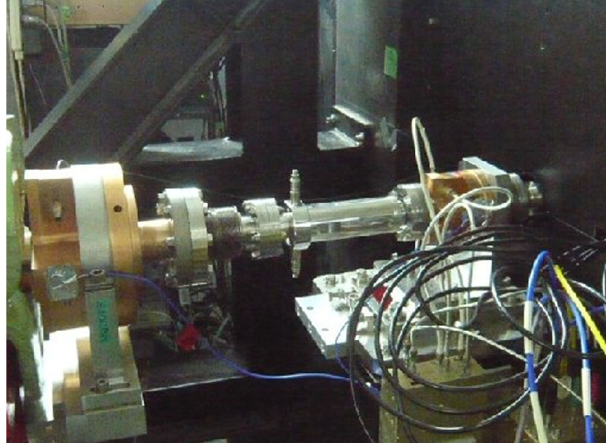
FIG. 13. Photograph of the IP stripline kicker.